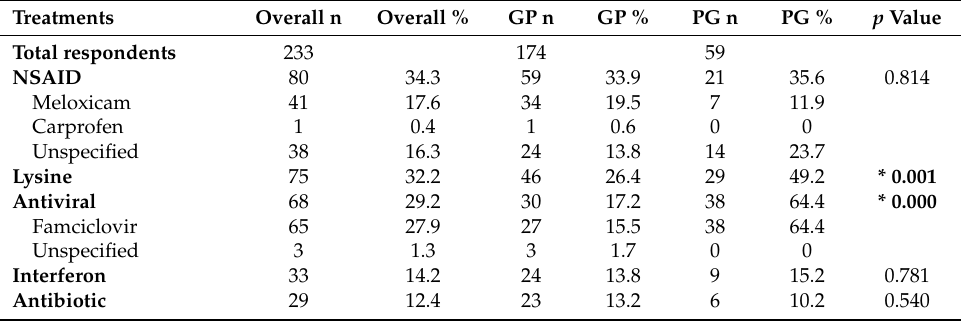
Table 7. FHV ‐ 1 keratitis systemic therapies recommended by GP and PG groups responding to a vignette questionnaire.